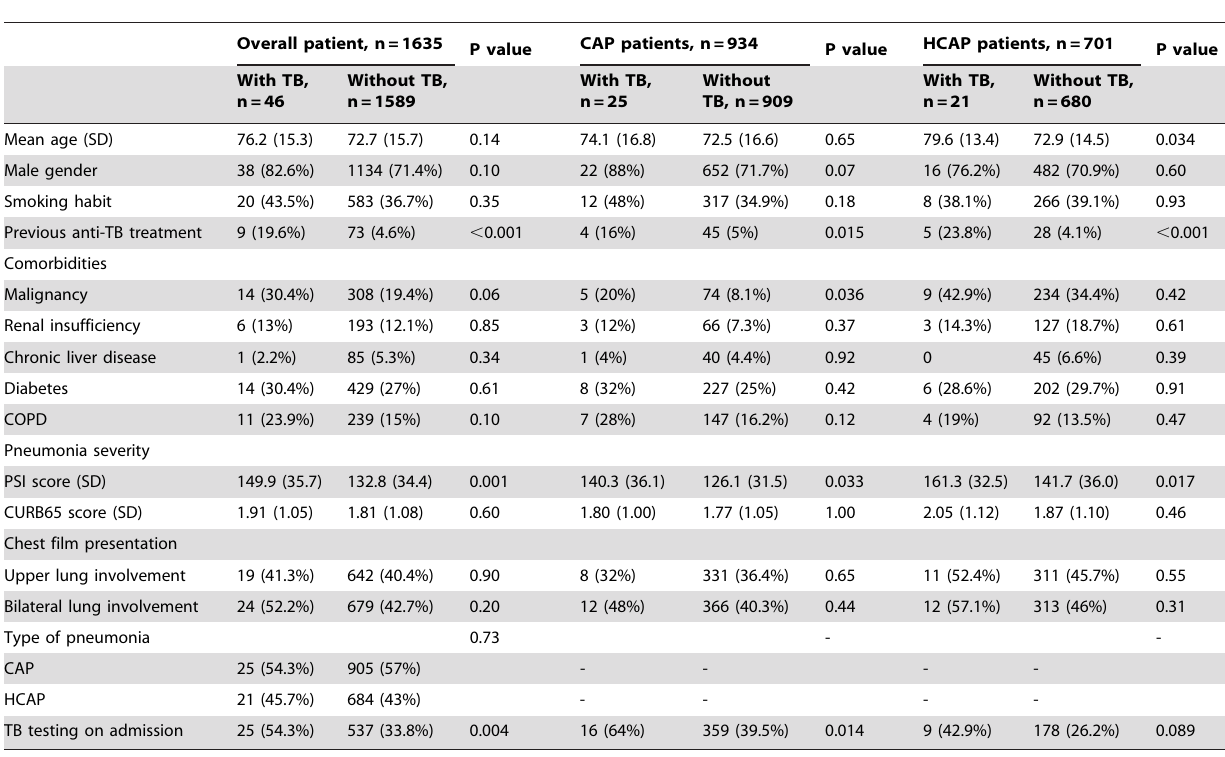
Table 2. Demographic profiles and clinical characteristics of CAP and HCAP patients with and without concomitant pulmonary tuberculosis a